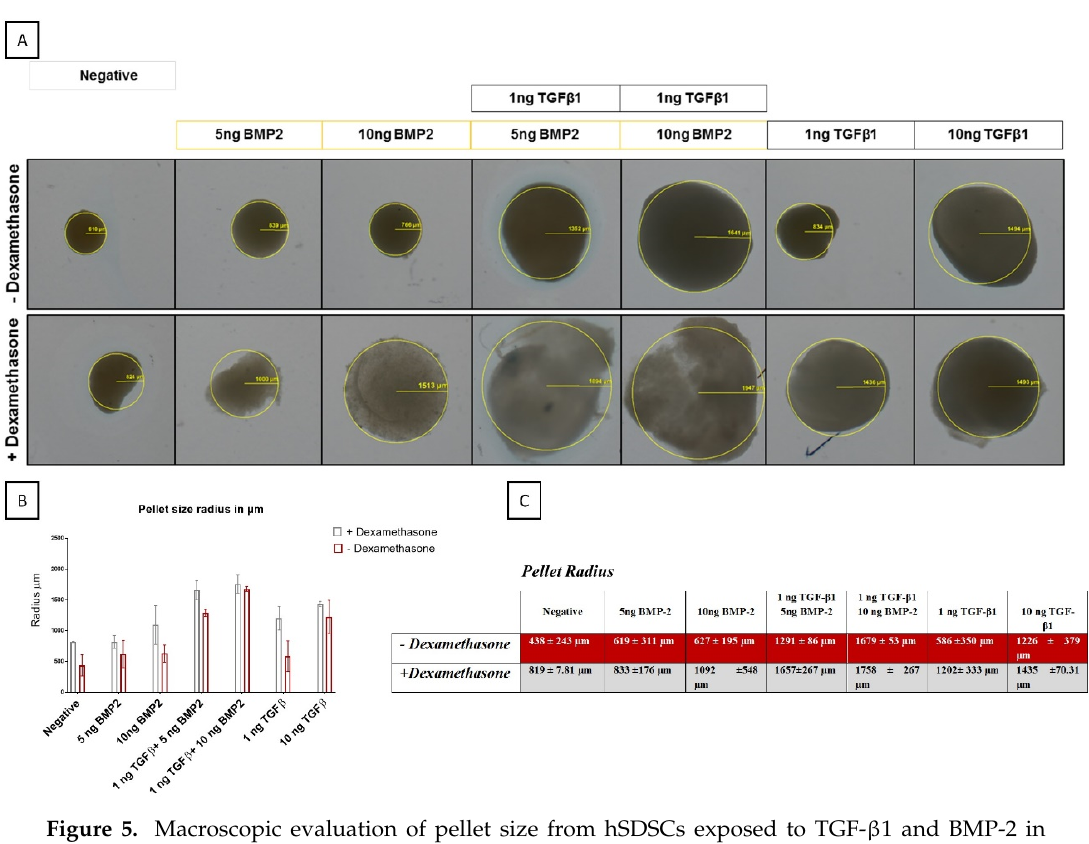
Figure 5. Macroscopic evaluation of pellet size from hSDSCs exposed to TGF- β 1 and BMP-2 in the presence or absence of dexamethasone. hSDSCs in 3D culture were cultures for 21 days in the presence of 10 ng/mL TGF- β 1 (positive control) or in its absence (negative), low TGF- β 1 concentration (1 ng/mL TGF- β 1), various concentrations of BMP-2 alone (5 ng/mL BMP-2, 10/mL ng BMP-2) or BMP-2 in combination with 1 ng TGF- β 1 (1 ng/mL TGF- β 1 + 5 ng/mL BMP-2 and 1 ng/mL TGF- β 1 + 10 ng/mL BMP-2). The figures are representative of four separate experiments in four different donors ( A ). Radius sizes are expressed in μ m ( B – C ). Radius pellet measured with Axio Plan Microscope objective 2.5×.